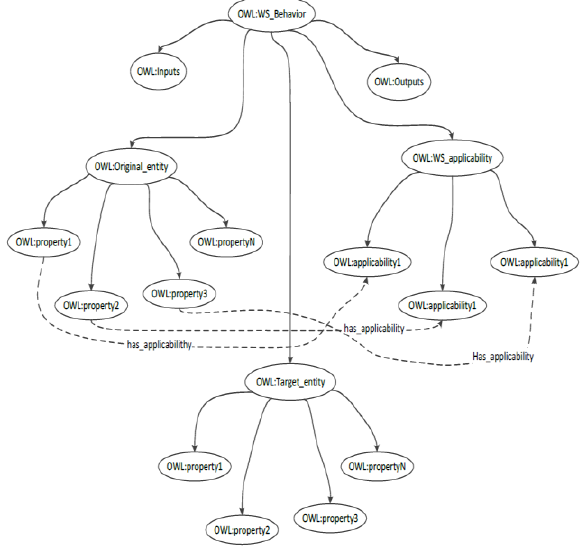
Figure. 4 Framework for expression service